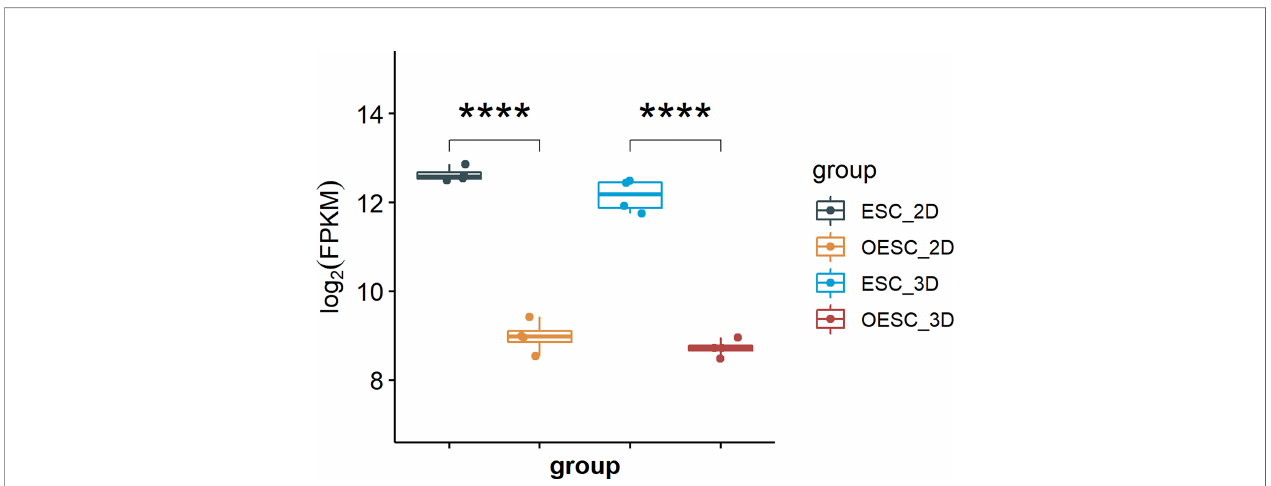
FIGURE 1 | The mRNA expression of HOXA10 in ESC and OESC (ESC_2D, ESC cultured in 2D system; OESC_2D, OESC cultured in 2D system; ESC_3D, ESC cultured in 3D system; OESC_3D, OESC cultured in 3D system.